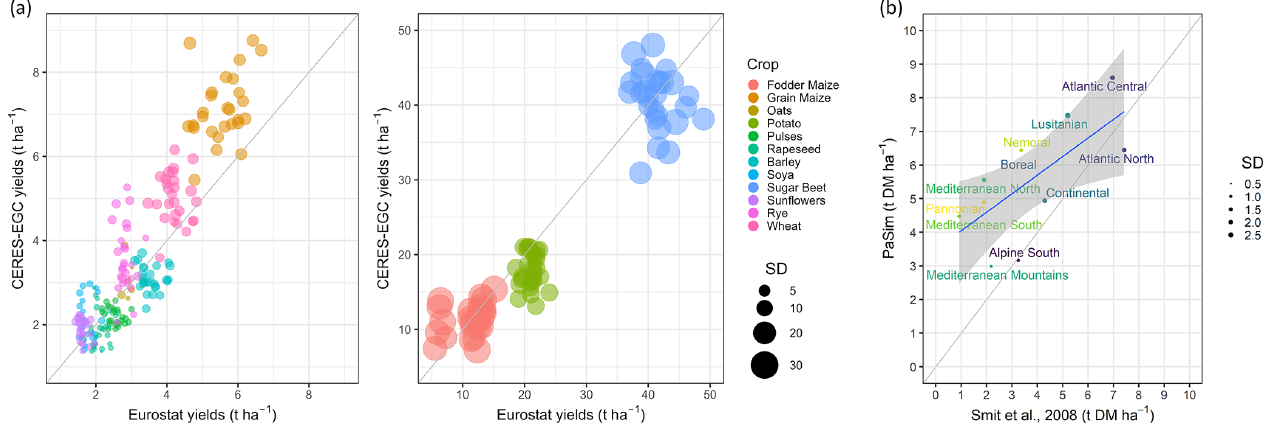
Figure 1. (a) Simulated crop yields compared with Eurostat statistics in the period 1978–2004. Each point represents the yearly yield over the EU for each crop; yields are reported as standard humidity. (b) Grassland production compared to Smit et al. (2008) for the period 1995–2004. Point size represents the standard deviation (SD) of the simulated